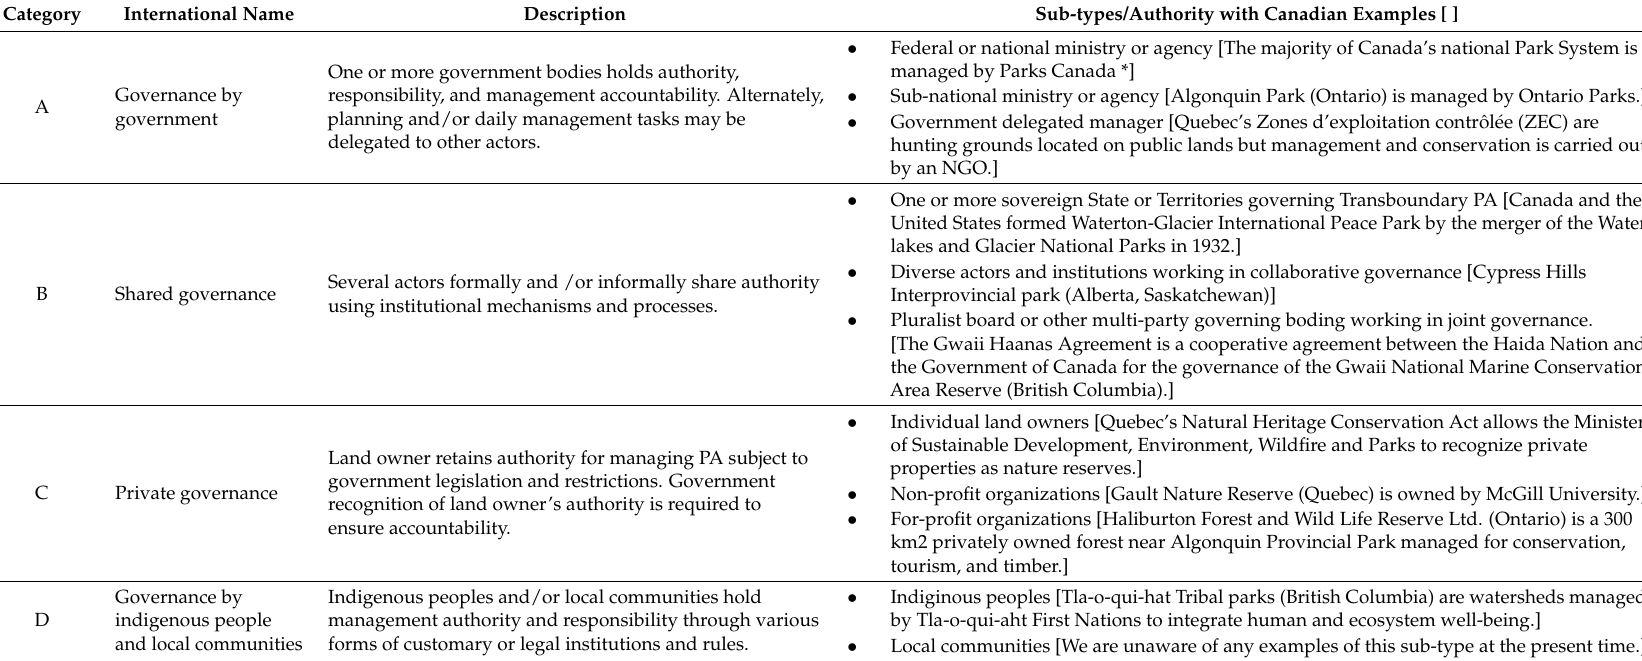
Table 5. IUCN governance categories for protected areas with Canadian examples ** (adapted from IUCN